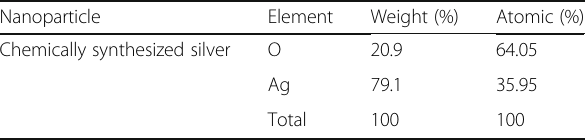
Table 1 Elemental analysis of chemically synthesized AgNPs